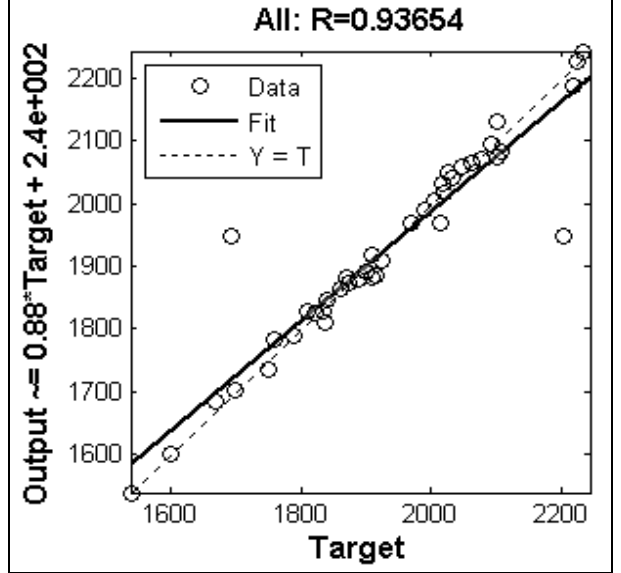
Figure 4. The regression graph for experimental results and prediction data for nanofluid hybrid.